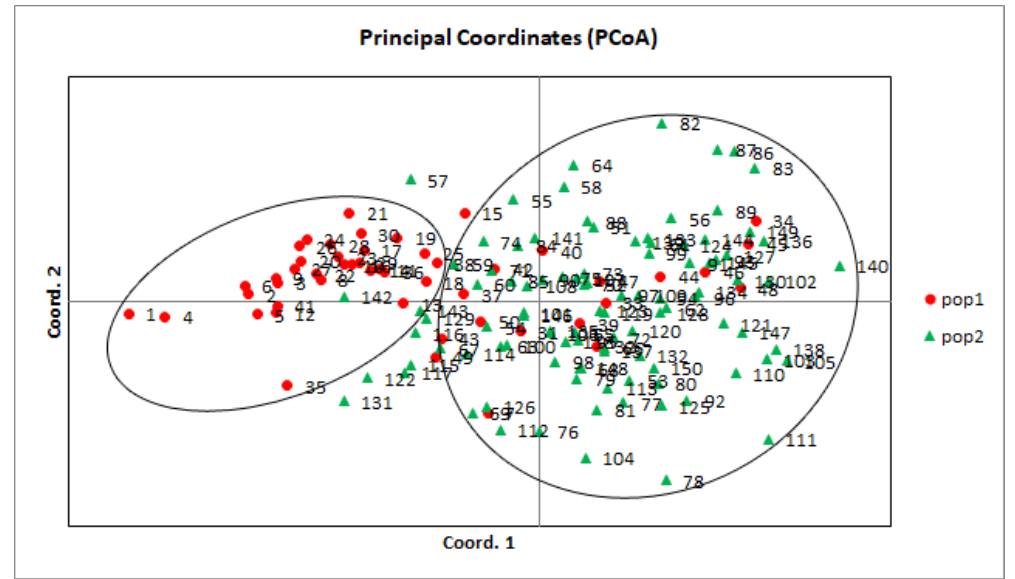
Figure 2. Principal coordinates analysis (PCoA) scatter plots. Red circles represent the Pop1 clones and green triangles the Pop2 clones.